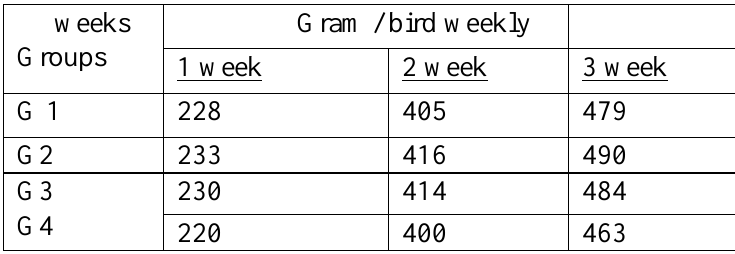
Table-1: Effect of difference concentration of β-glucan extract on average of Feed intake (gram /bird weekly) .